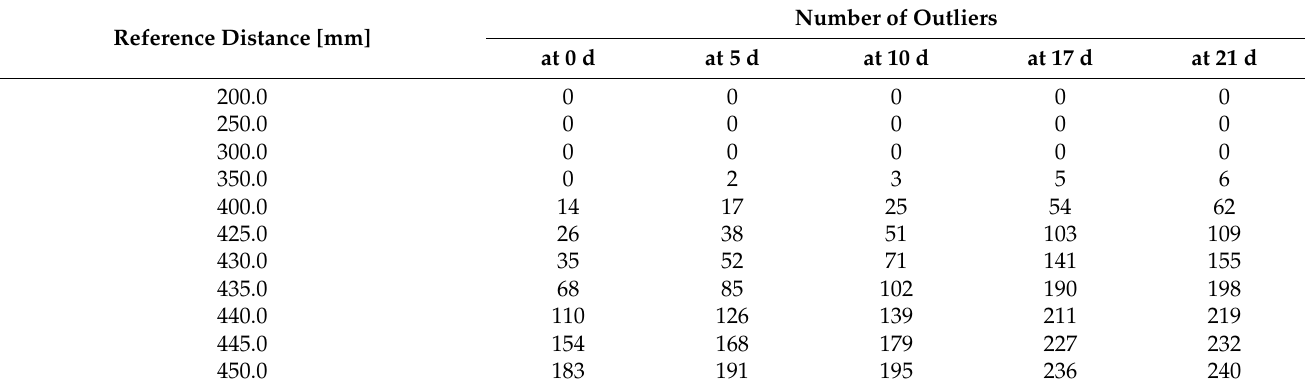
Table A1. Influence of the accelerated aging on the number of outliers (Figure 9a).